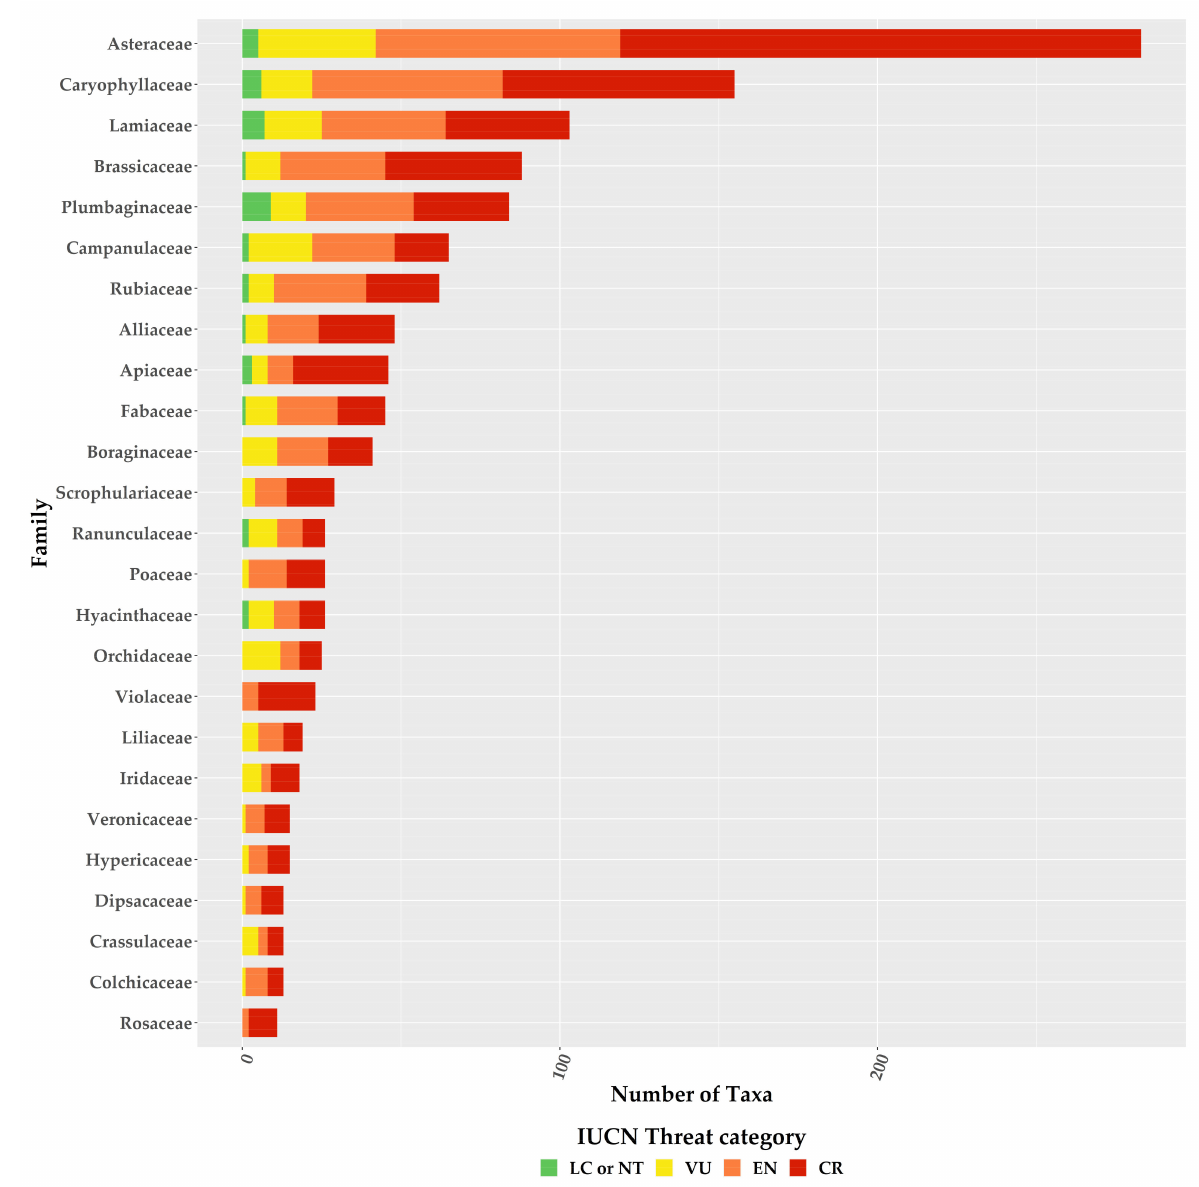
Figure 4. Proportion of the Greek endemic taxa under the IUCN threat categories according to both Criterion A and B for the richest plant families. Please note that information is presented only for families with 10 or more Greek endemic